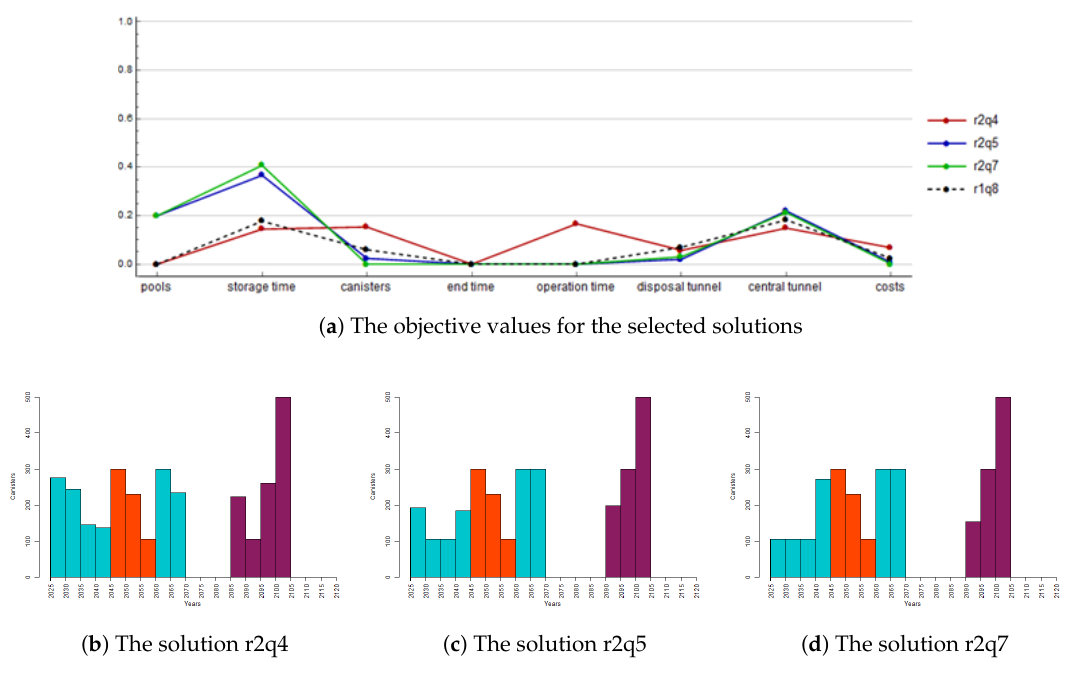
Figure 6. Results for iteration